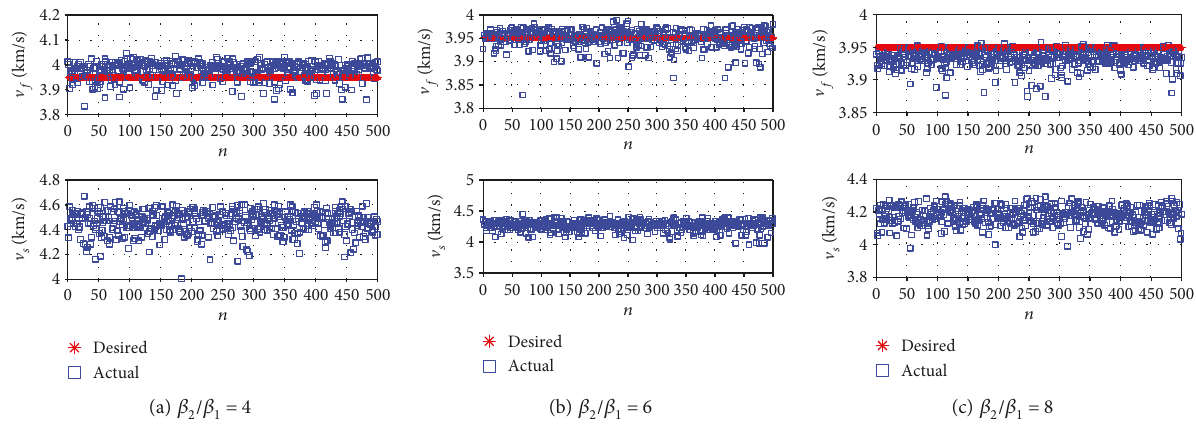
Figure 7: The distribution of terminal velocity and switching velocity.